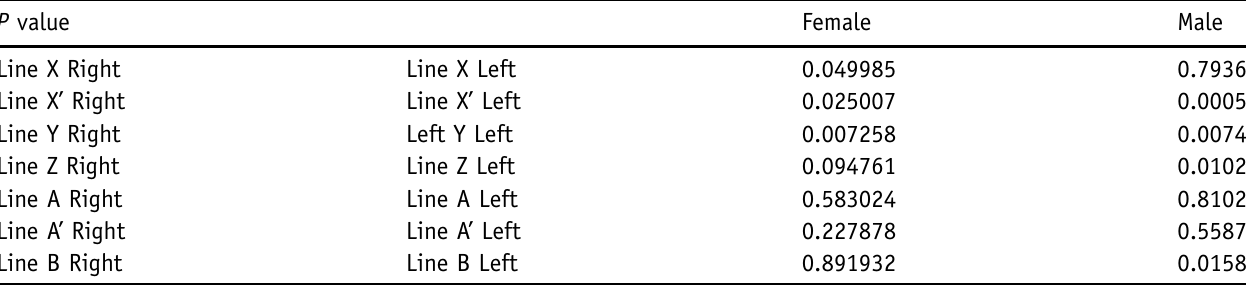
Table III. Sidewise and gender wise comparasion showing P